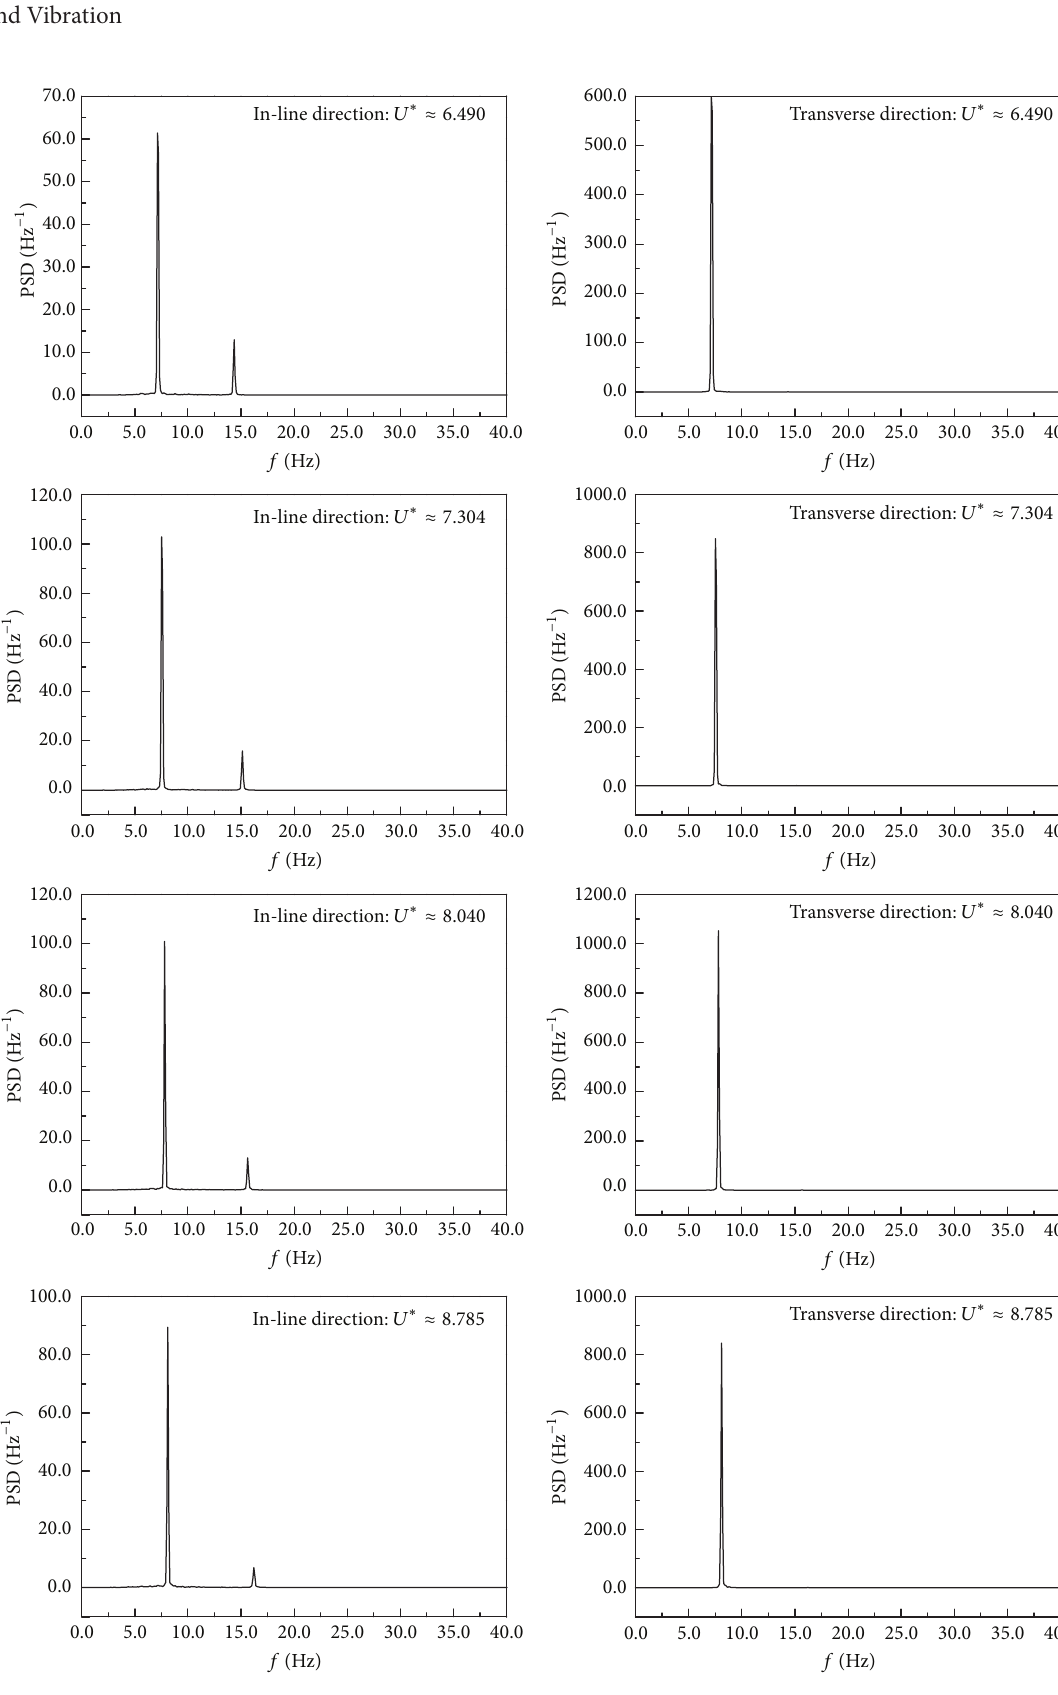
Figure 9: Power spectrum density functions of aluminum tube vibrations with the decreasing of flow